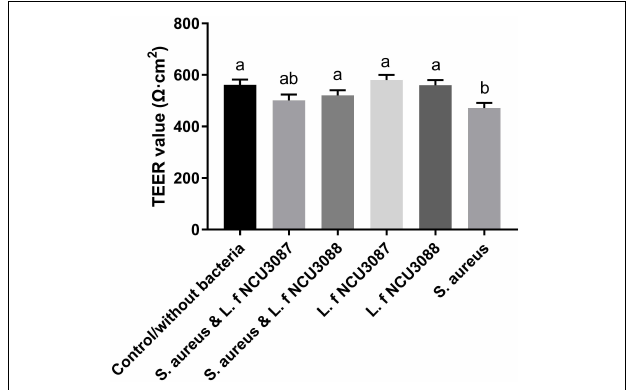
FIGURE 3 | TEER level of Caco-2 monolayer after incubation with bacteria. The experiments were performed in triplicate, and the data are mean ± SD. Different letters indicate statistically significant differences between variables.